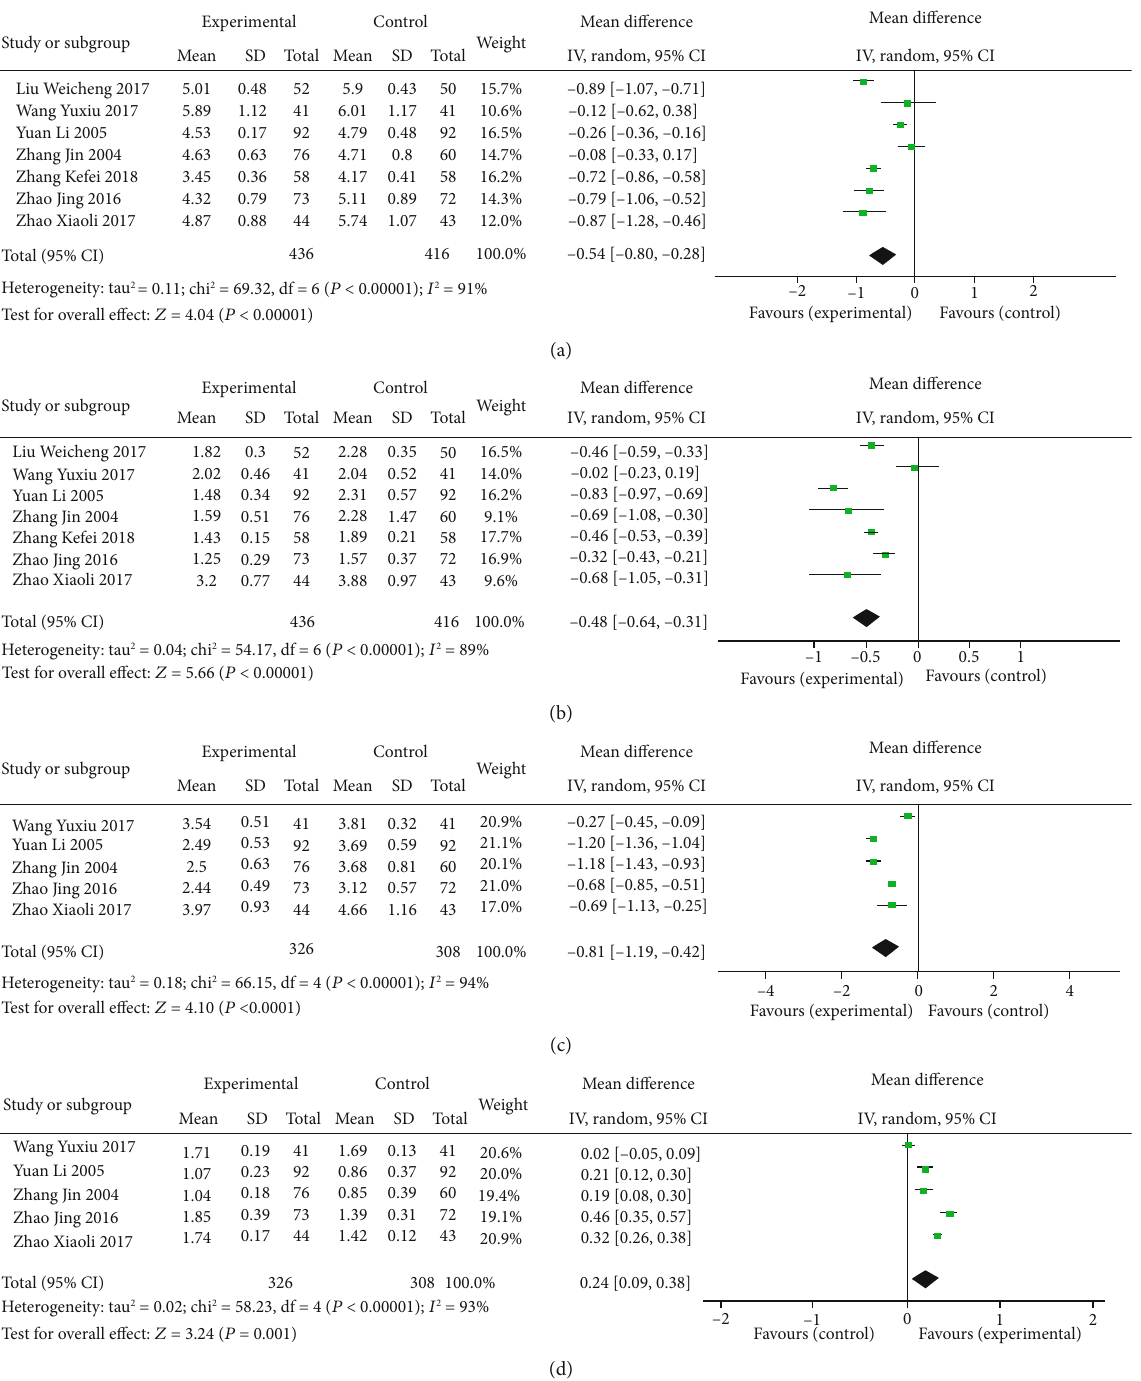
Figure 5: Forest plot of indices of blood lipid in patients treated with TCMs and routine treatment. (a) The plot of TC, (b) the plot of TG, (c) the plot of LDL, and (d) the plot of